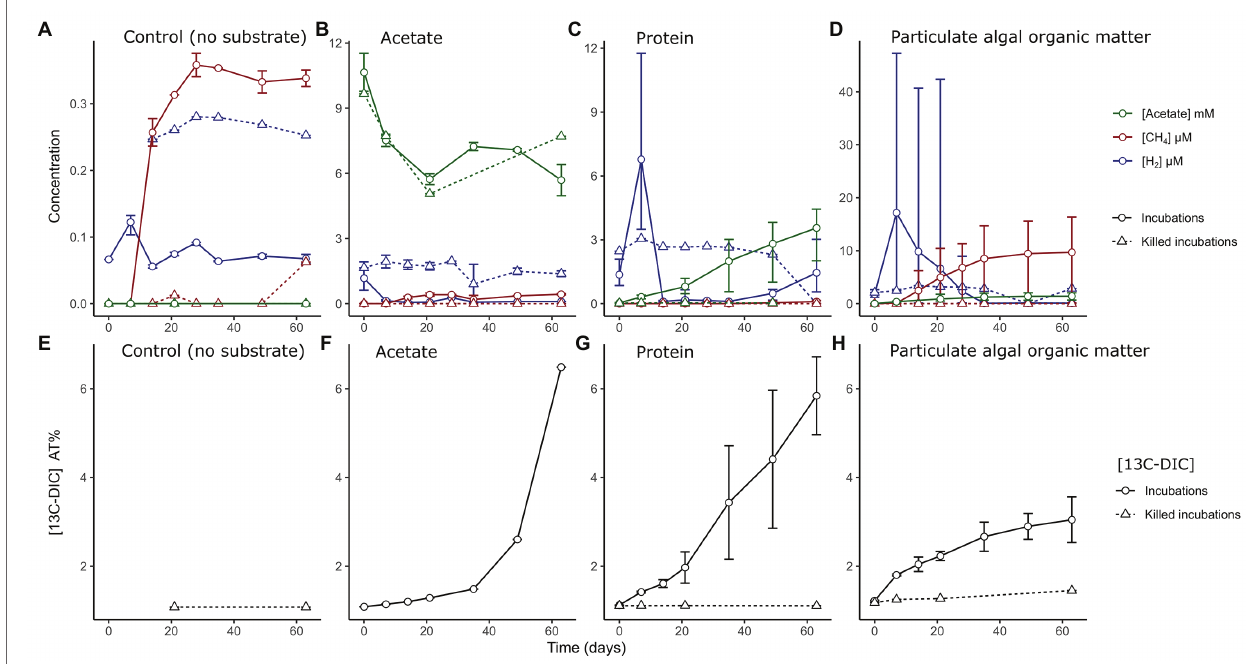
FIGURE 1 | (A–D) Measured concentrations of hydrogen (blue, μ M), methane (red, μ M), and acetate (green, mM) in sediment slurries in control incubations without added substrate and in incubations amended with different organic matter types as indicated in the text. Measurements from incubations with both labeled and unlabeled substrates are combined. Note the different ranges of the y-axis. (E–H) Measured accumulation of 13 C isotope fraction in dissolved inorganic carbon (DIC) as percentage in the different incubations and heat-killed controls. Solid lined represent live incubations, while dashed lines represent measurements from abiotic (killed) controls. Error bars depict the range of ( n = 2–6)